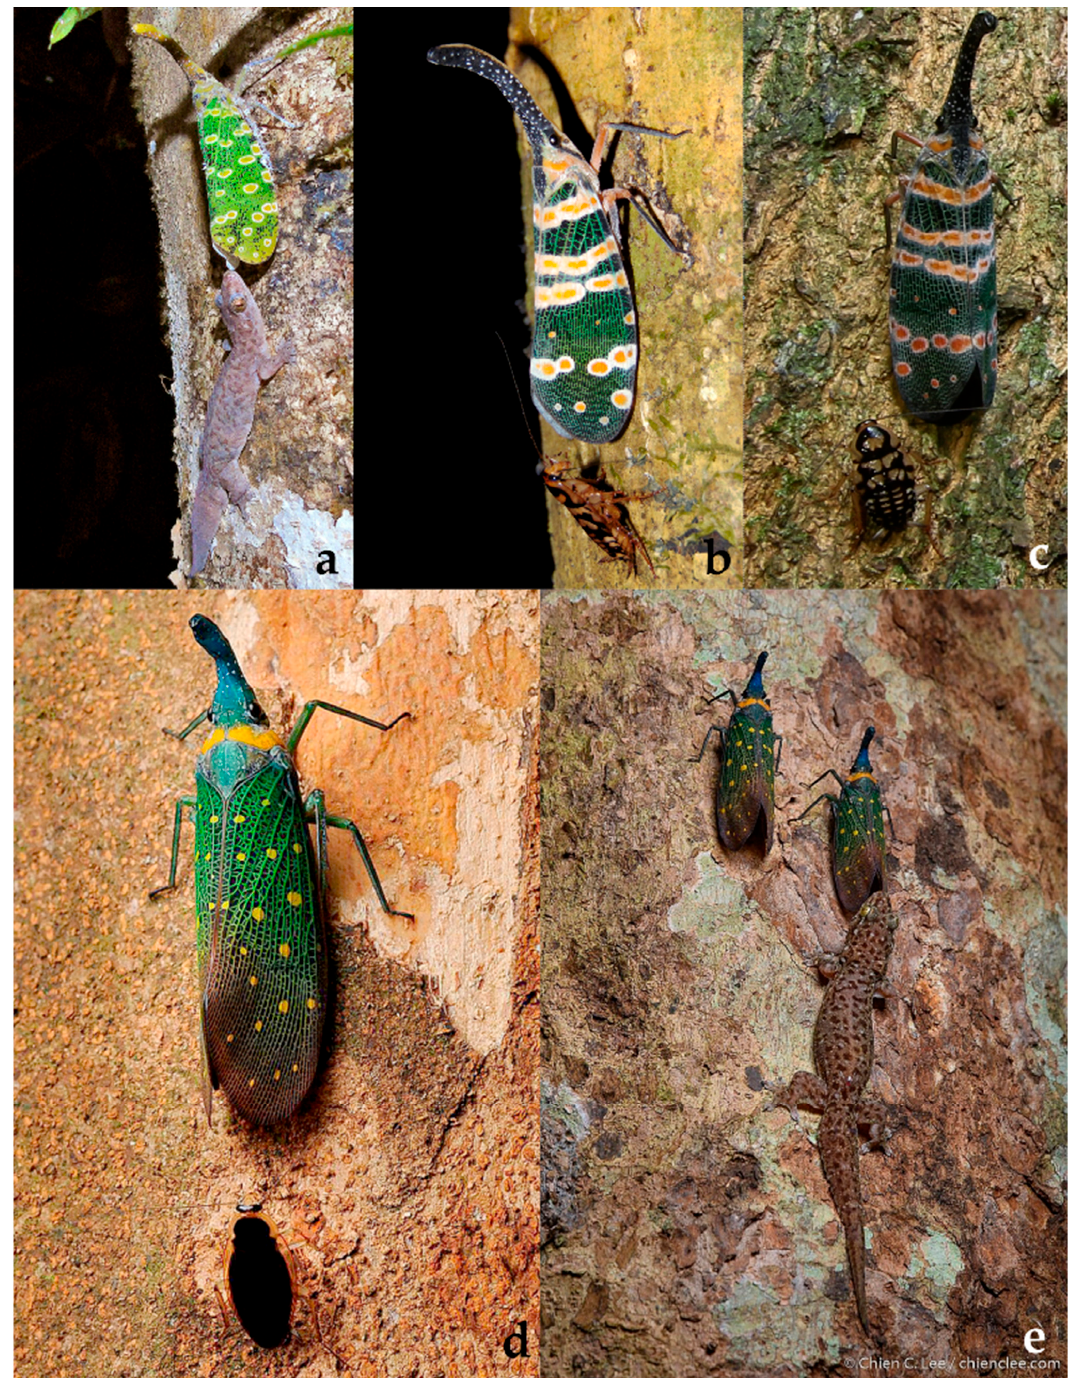
Figure 18. Fulgoridae: ( a ) Pyrops sidereus (Distant, 1905) tended by Reptilia: Squamata: Gekkonidae indet., Malaysia: Borneo, Sabah, Abai, Kinabatangan River, 5°41 ′ 16 ″ N 118°23 ′ 01 ″ E, 13.05.2015, adult on tree trunk, obs. R.K. Asuncion; ( b ) P. spinolae (Westwood, 1842) tended by Blattodea indet., Vietnam: Kon Plong Protected Forest, 14°39 ′ 43 ″ N 108°15 ′ 45 ″ E, 20.08.2019, adult on tree trunk, obs. J. Constant; ( c ) P. spinolae tended by Blattodea indet., Thailand: Suan Phueng District Ratchaburi, 13°32 ′ 54.9 ″ N 99°12 ′ 24.2 ″ E, 10.08.2021, adult on tree trunk, obs. K. Jiaranaisakul; ( d ) P. whiteheadi (Distant, 1889) tended by Blattodea indet., Malaysia: Danum Valley Conservation Area, 4°57 ′ 48.1 ″ N 117°48 ′ 19.5 ″ E, 15.12.2008, adult on tree trunk, obs. C. Lee; ( e ) P. whiteheadi tended by Reptilia: Squamata: Gekkonidae: Gehyra mutilata (Wiegmann, 1834), Malaysia: Sabah, 5°44 ′ 03.0 ″ N 117°48 ′ 44.8 ″ E, 09.2018, adults on tree trunk, obs. C. Lee (https://www.inaturalist.org/observa- tions/79122196 (accessed on 2 Octomber 2022).